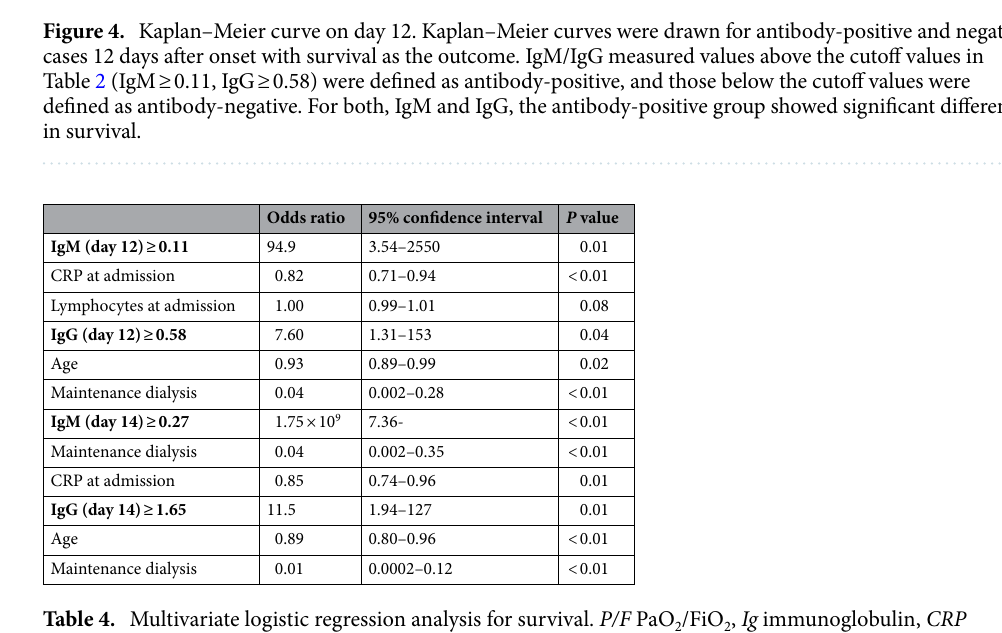
Table 4. Multivariate logistic regression analysis for survival. P/F PaO 2 /FiO 2 , Ig immunoglobulin, CRP C-reactive